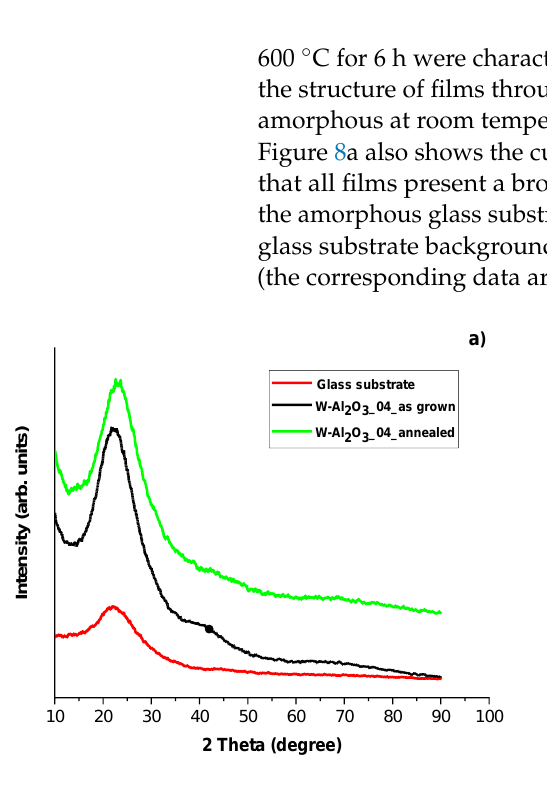
Figure 8. X-ray diffraction patterns of the W-Al 2 O 3 _04 sample before and after thermal treatment, collected at an incidence angle of 3.5° to the ( a ) glass substrate and ( b ) c-Si substrate.